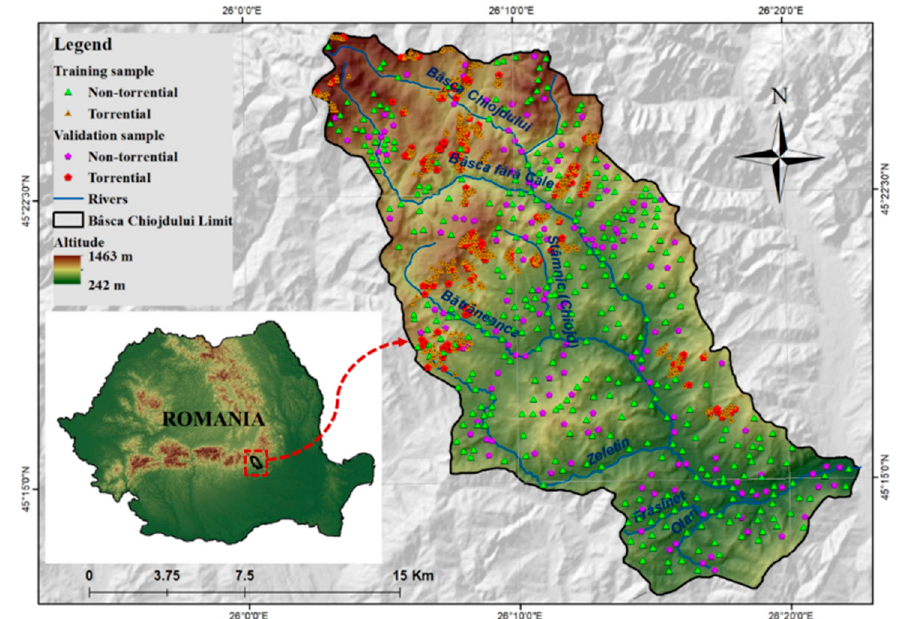
Figure 1. Study area